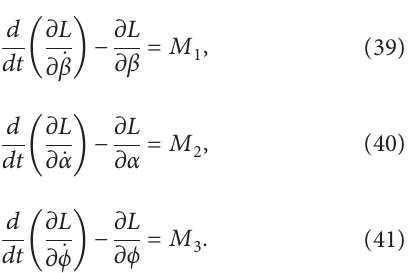
Figure 23: Measurement tracking setting: (a) tracking setting of rotating speed signal channel of the primary flywheel; (b) tracking setting of rotating speed signal channel of the input shaft of the